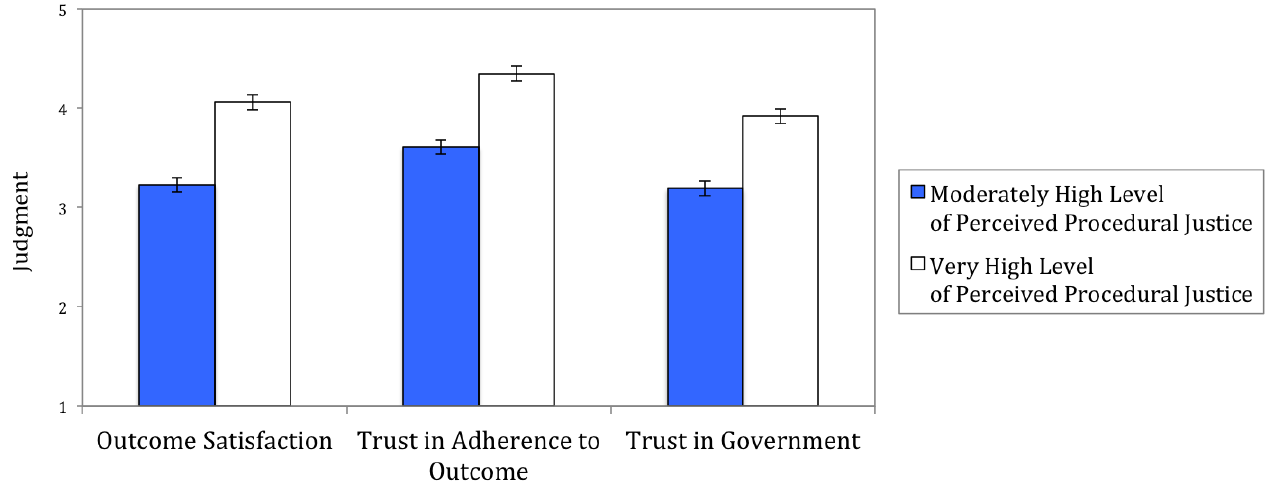
Figure 1 . Citizens’ satisfaction with outcomes, trust in adherence to the outcomes, and trust in the government as a function of their perceptions of procedural justice (moderately high level [-1 SD ] versus very high level [+1 SD ]). Judgments are on 5-points scales with higher values indicating higher levels of satisfaction or trust. Error bars represent standard errors of the mean.